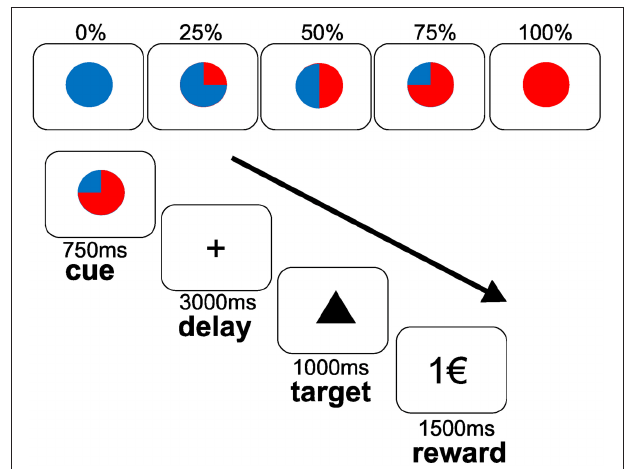
FIGURE 1 | Monetary incentive reward paradigm during fMRI. The upper panel depict cues that indicated the varying reward probabilities (0, 25, 50, 75, and 100%). The lower panel depicts the course of the task. Subjects were instructed to expect a reward of 1 e at the announced probability (cue) during the delay (expectancy period). After the presentation of a target stimulus (triangle as shown or a square), participants had to response by a button press on a two-button box with their right index finger to the triangle target or with their right middle finger to the square target within a fixed time threshold of 1,000ms. Reward was displayed for 1,500ms with regard to the previously announced probability (outcome period).